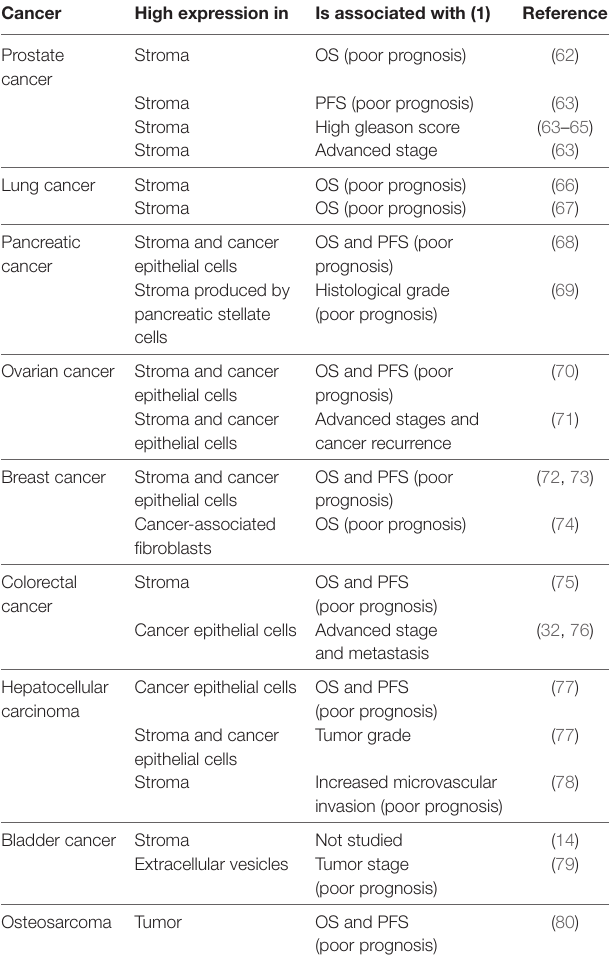
TAbLe 1 | Correlation between periostin expression levels and clinical parameters in solid tumors.